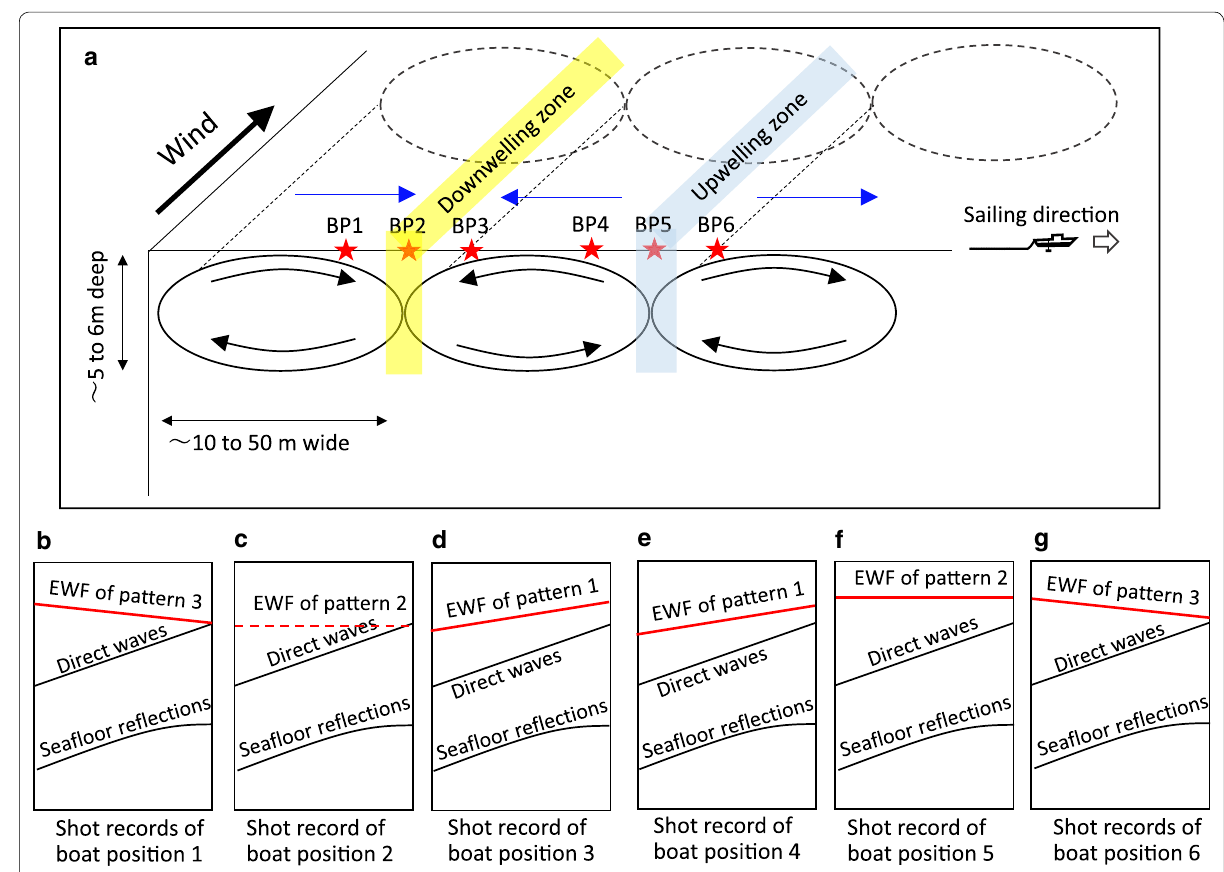
Fig. 12 a Conceptual diagram of a possible cause of the EWFs observed on lines 14 and 16. Those EWFs may be explained by wind‑induced downwelling and upwelling water movements known as the Langmuir circulation, which involves the development of a series of convective cells with ~ 10 to 50 m wide and ~ 5 to 6 m deep (Pinet 1998). According to the weather information service of Japan Meteorological Agency (2020), the average wind speed during the survey was 4.1 m/s from the northeast, whose speed is responsible for the formation of the Langmuir cells. BP represents boat position. b This figure shows the EWF pattern 3 on line 14 observed in the downwelling zone at boat position 1. c The EWF pattern 2 on line 14 at boat position 2. d The EWF pattern 1 on line 14 at boat position 3. e The EWF pattern 1 on line 16 observed in the upwelling zone at boat position 4. f The EWF pattern 2 on line 16 at boat position 5. g The EWF pattern 3 on line 16 at boat position